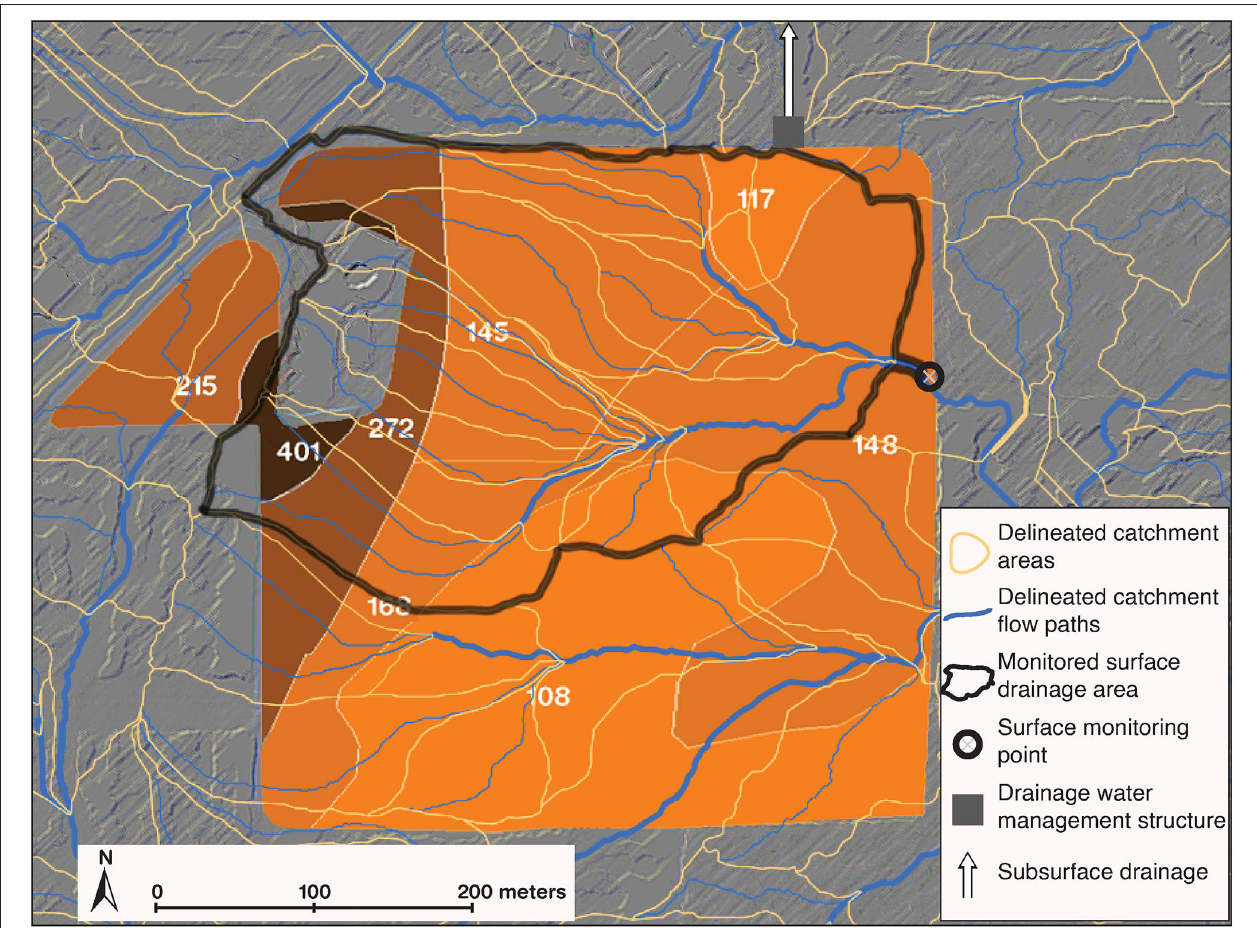
FIGURE 4 | Surface water flow paths across a field (Site #2, Table 1 ) selected for this study. This site image depicts the isolated and concentrated hydrology sought for monitoring following the delineation of catchment areas and their respective flow paths (see legend in the bottom-right). Areas of the field are labeled and shaded according to the local STP concentration in units of mg P kg − 1